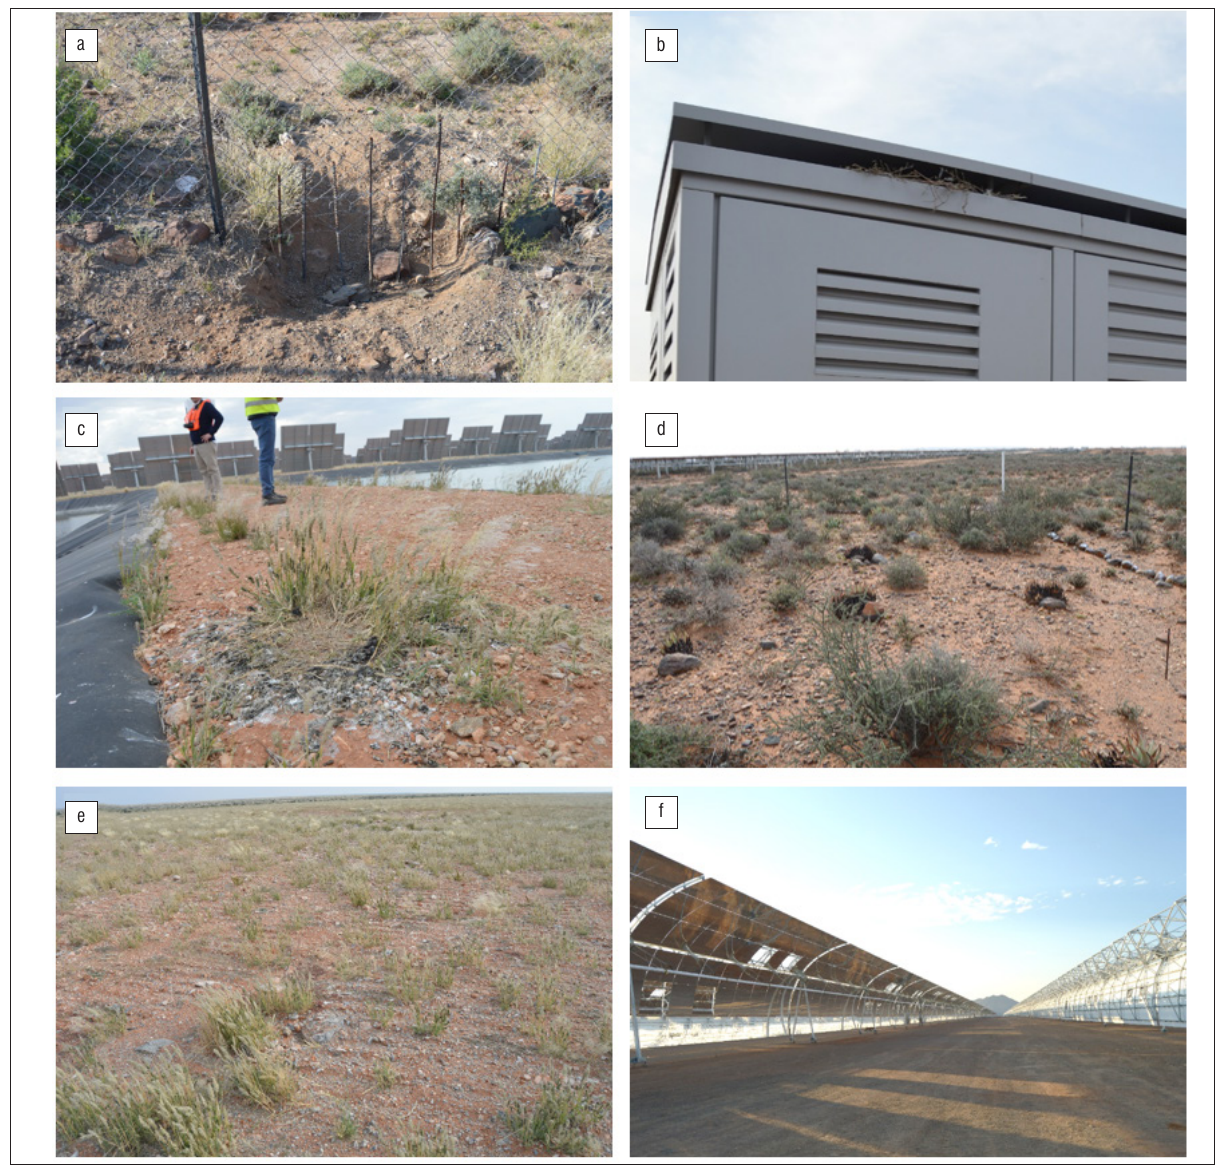
Photographs of key observations made during site visits (as reported in Table 4). (a) An example of how animals burrow underneath the development fence and an improvised attempt to keep them out at Site 3. (b) A nest in a small opening at the top of a transformer building at Site 4. (c) An empty nest at the edge of an evaporation pond at Site 5; some of the heliostats of the solar field are visible in the background. (d) One of the ‘green areas’ at Site 4 where six kraal aloes were relocated from the solar field prior to construction. (e) The topsoil embankment at Site 5 during the early stages of rehabilitation. (f) A row of parabolic troughs at Site 6 showing the cleared and compacted ground of the solar